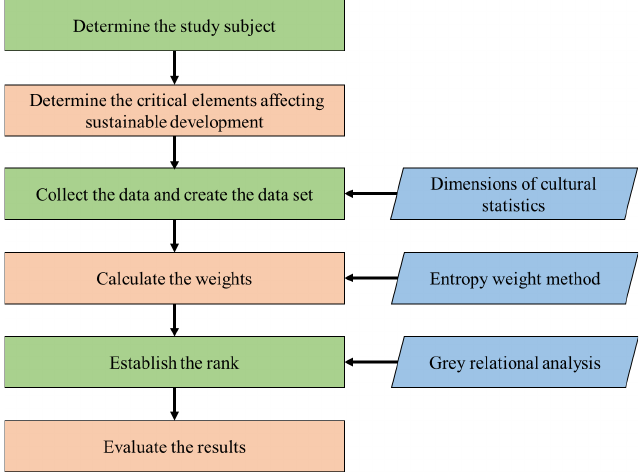
Figure 1. Methodological